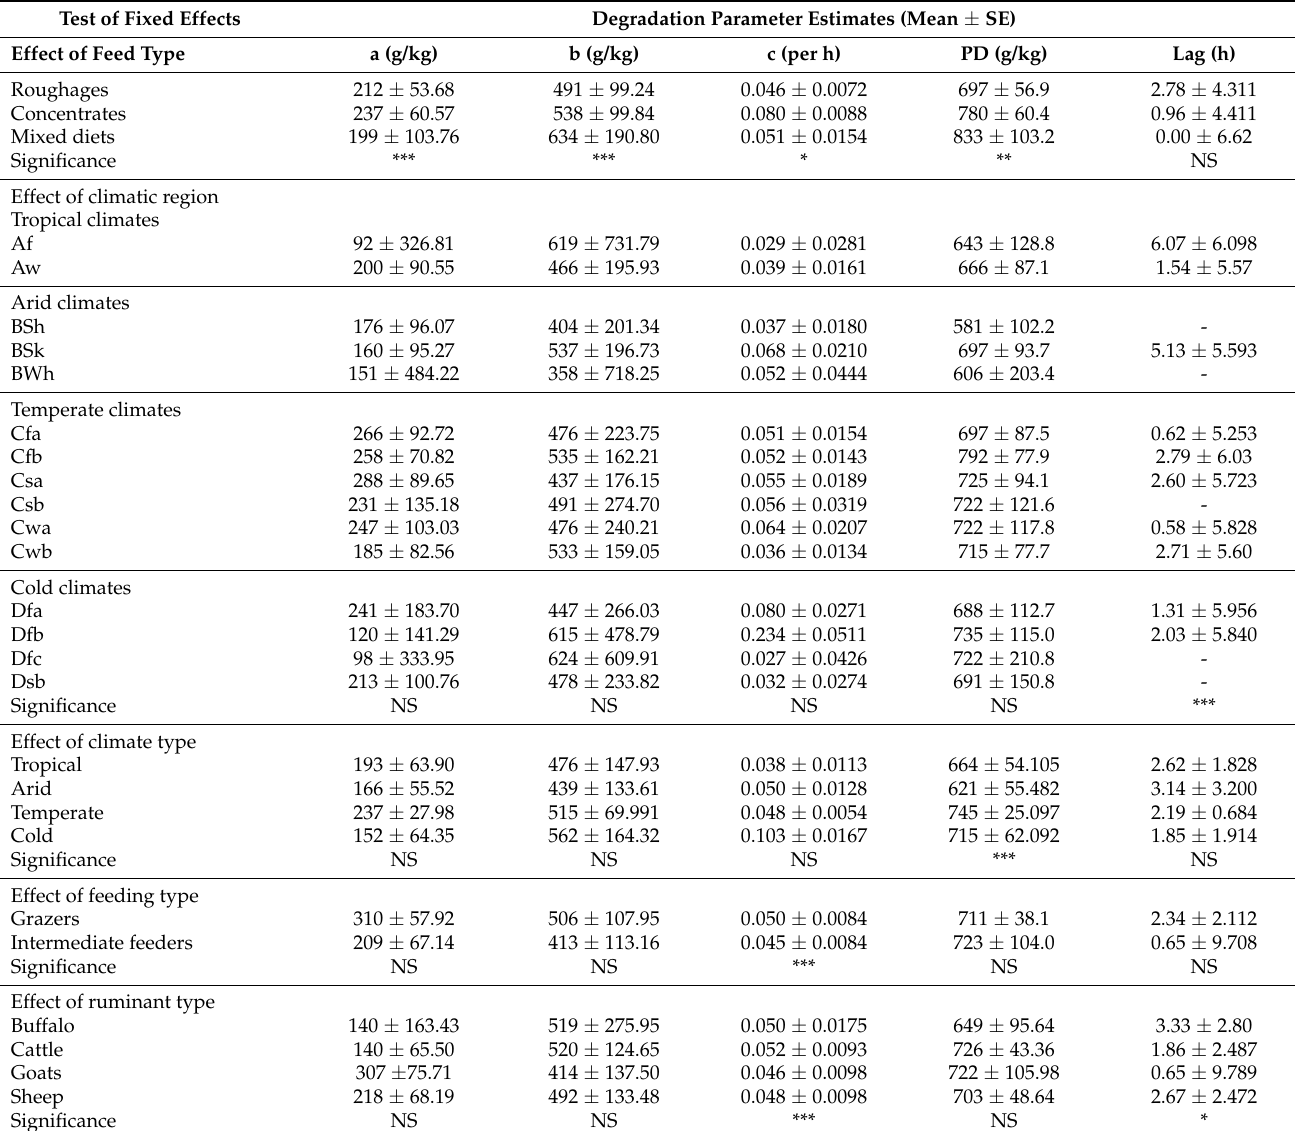
Table 3. Effects of feed sample and diet properties, ambient temperature, ruminant type, feeding type, and climatic region on rumen degradation of